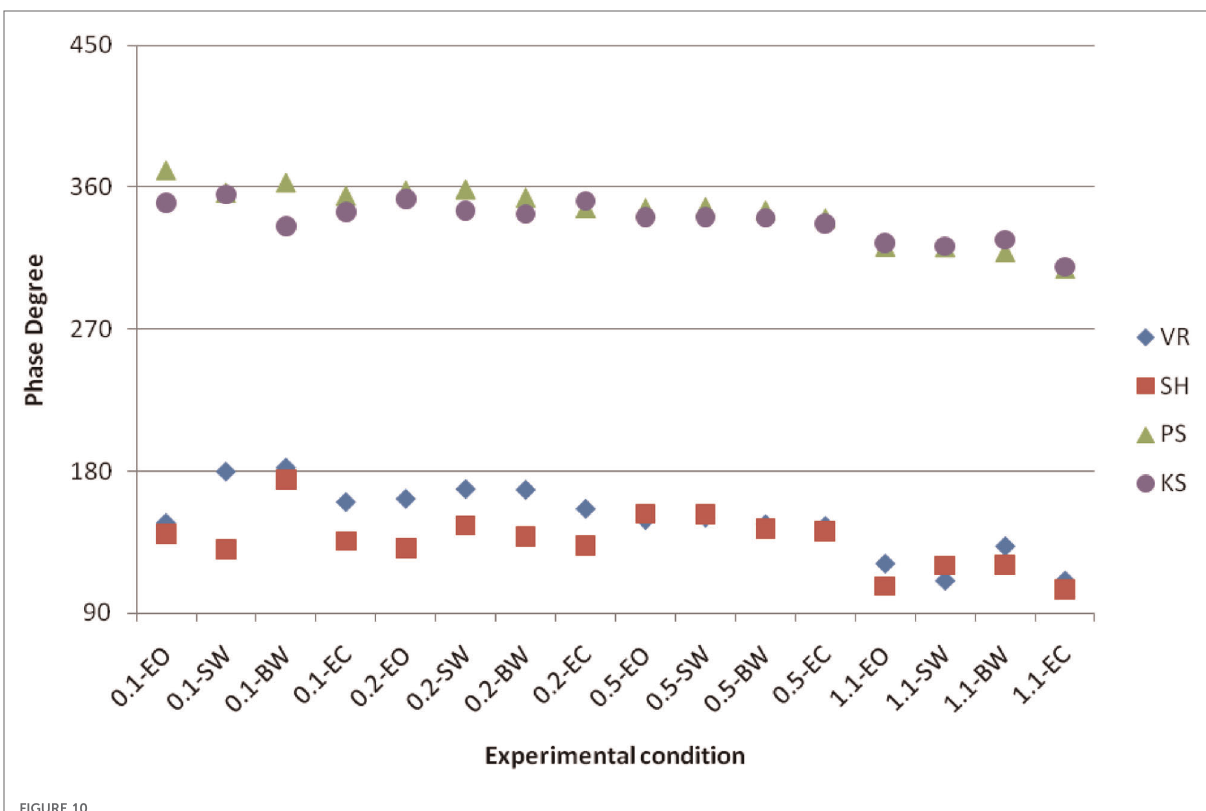
FIGURE 10 Phase of head acceleration relative to the sled.